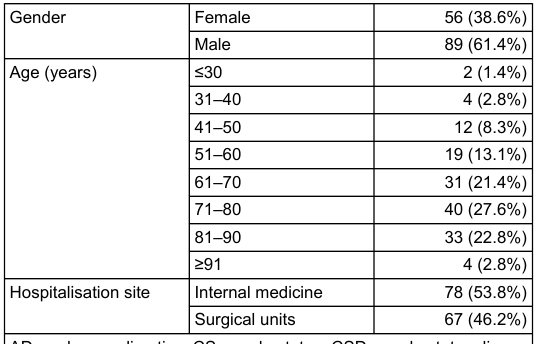
Table 1: a: Patients’ characteristics (n = 145).